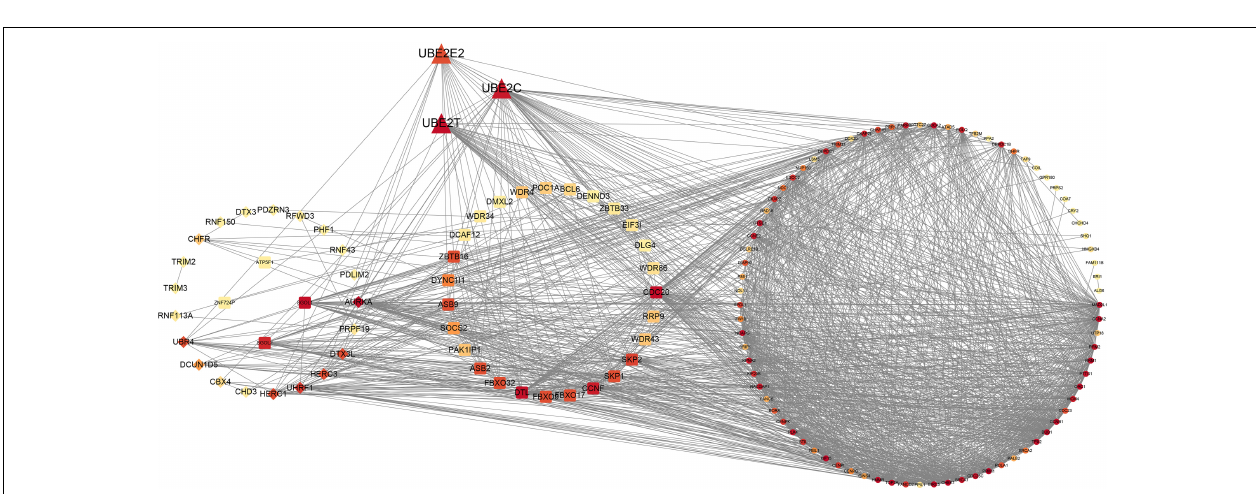
cell proliferation (Kastan and Bartek, 2004; Massagué,